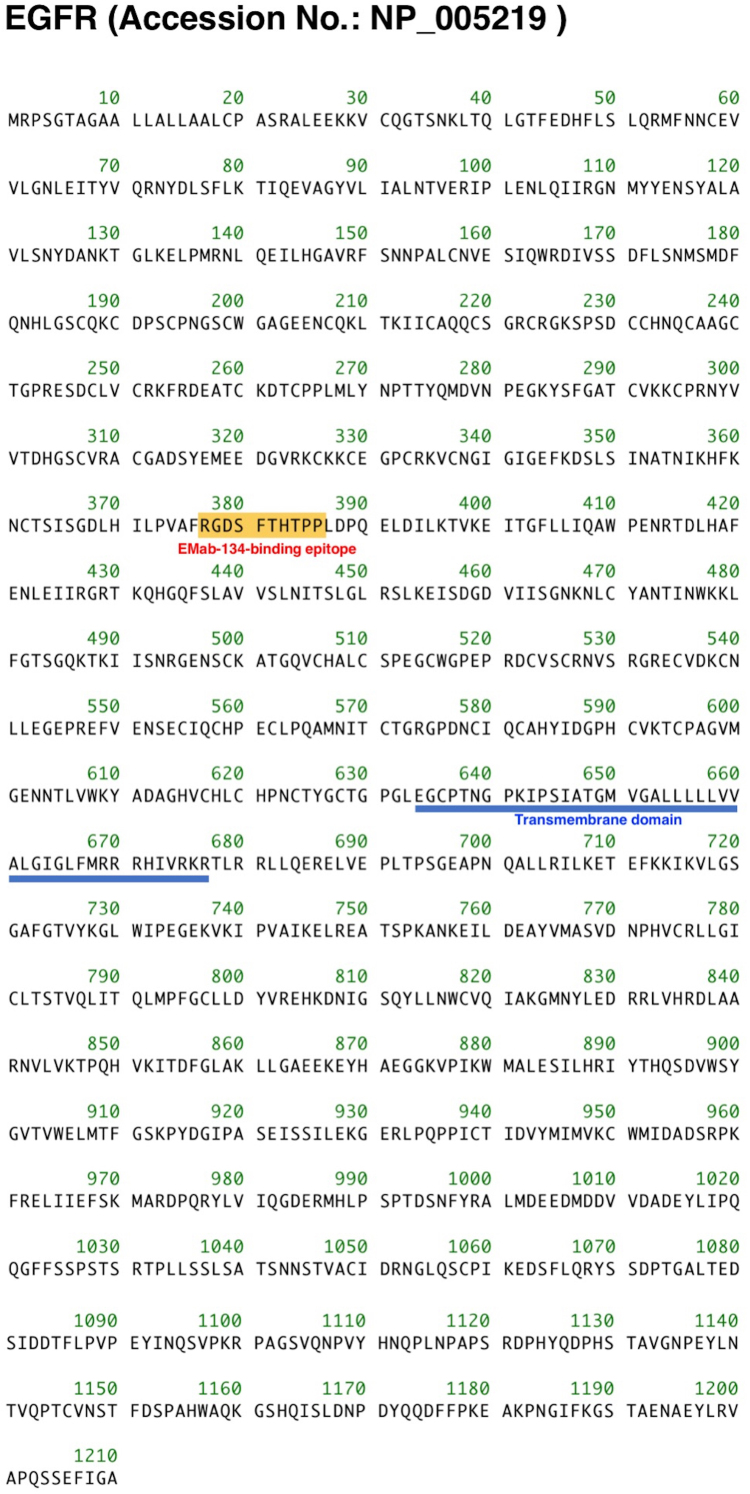
Amino acid sequence of EGFR.